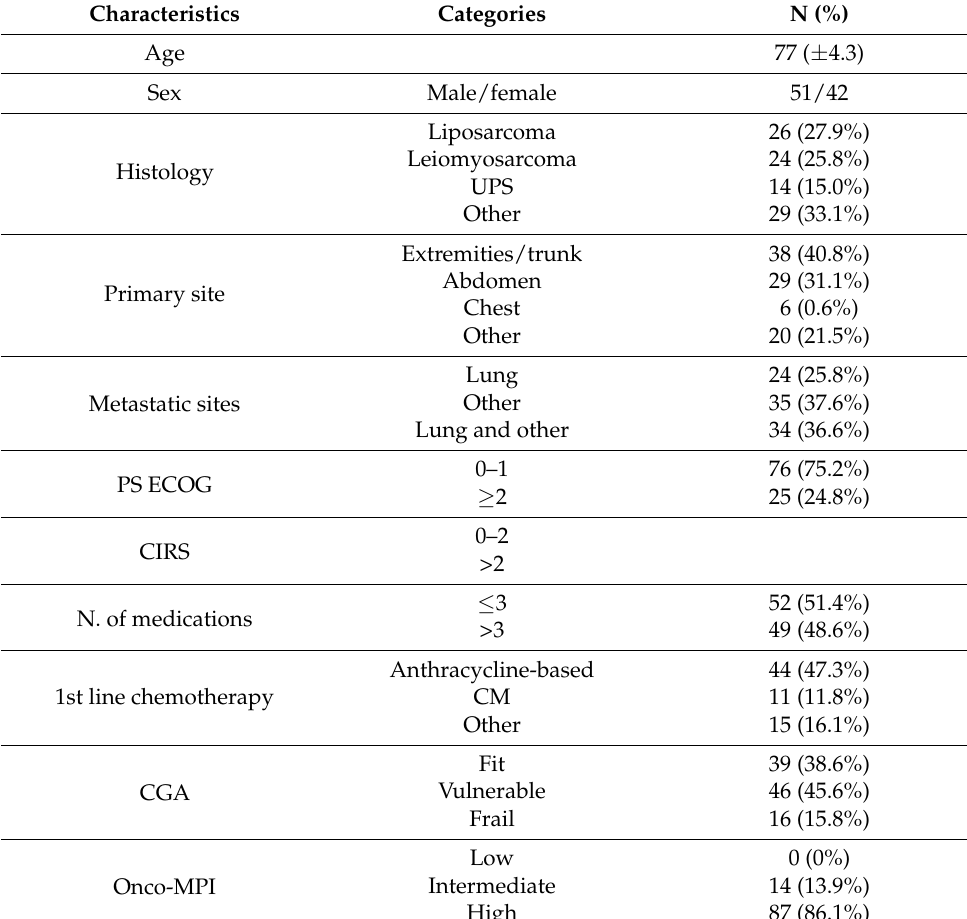
Table 3. Patient’s characteristics (N =